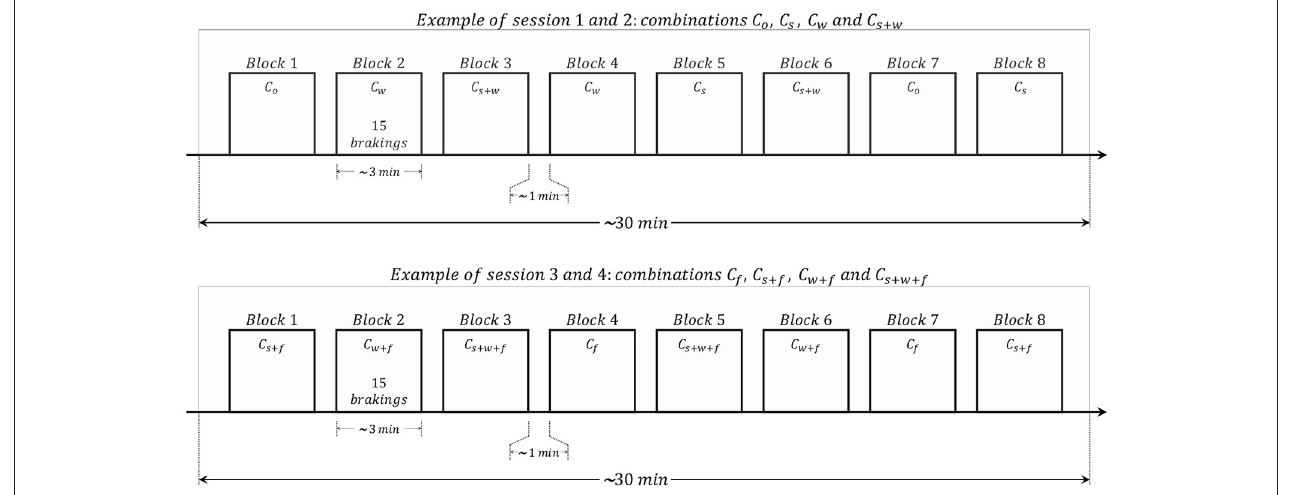
FIGURE 2 | Illustration of the temporal sequence of a morning session (Top) and an afternoon session (Bottom) . Each session consisted of eight blocks. Each block contained 15 emergency braking of the same experimental combination. The experiment was carried out in four sessions (two in the morning and two in the afternoon). In total, 120 emergency braking situations were presented in each session yielding to a total of 480 emergency braking situations per